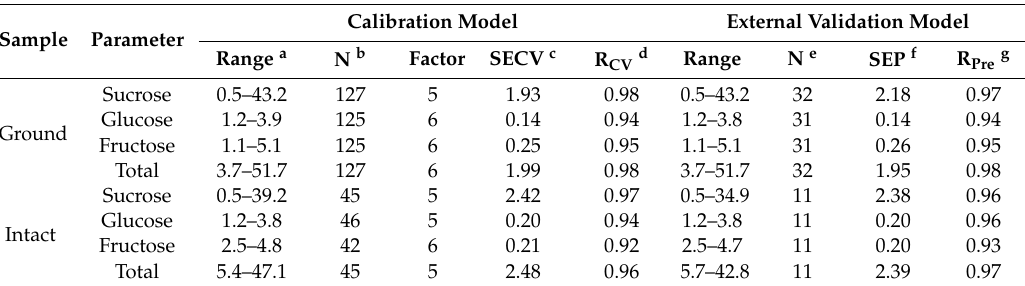
Table 2. Statistical performance of the prediction models developed using a handheld FT-NIR spectral sensor for predicting individual (sucrose, glucose, and fructose) and total sugar content in ground and intact breakfast